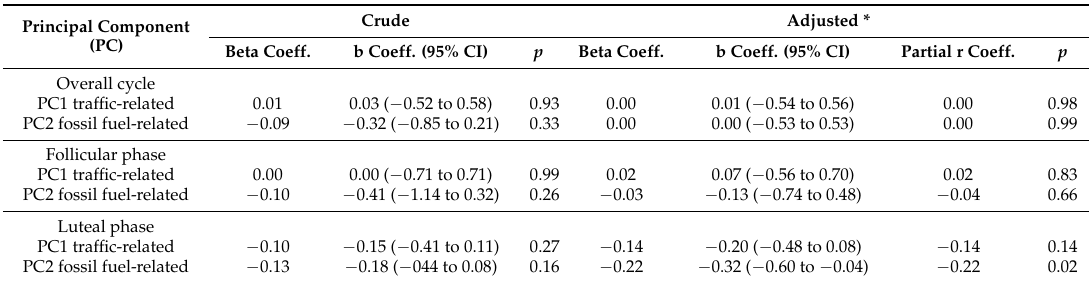
Table 4. The association between principal components (PCs) and menstrual overall cycle and phases length tested by simple and multiple regression analyses.